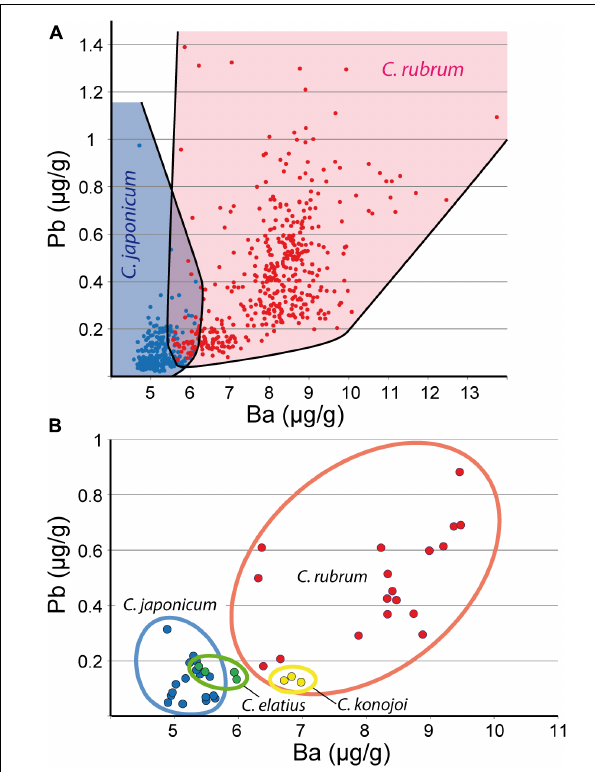
FIGURE 3 | Pb and Ba LA-ICPMS data. (A) Pb vs. Ba diagram showing the respective fields of C. rubrum and C. japonicum (all analyses). (B) Pb vs. Ba for C. rubrum, C. japonicum, C. elatius , and C . konojoi . Mean composition of analyzed colonies. Fields of C. elatius and C. konojoi are likely to expand with additional